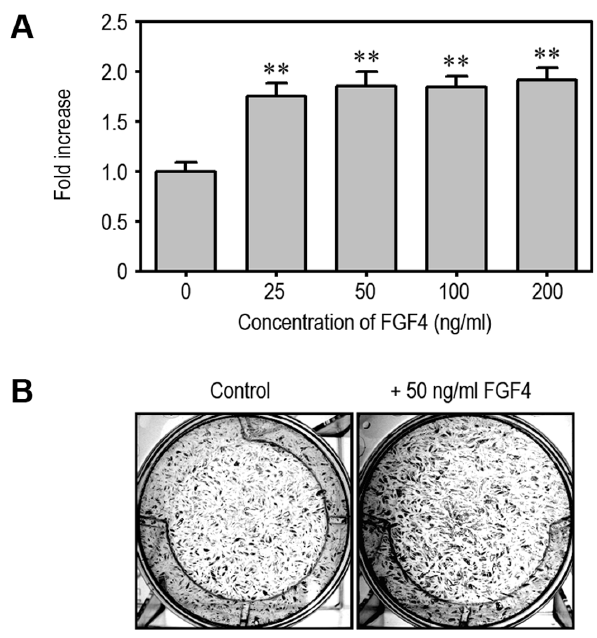
Figure 1. FGF4 increases proliferation of mESCs. mESCs were incubated in the presence of 0 to 200 ng/ml FGF4 in 96-multiwell plates or with the indicated concentration of FGF4 in 6-well culture plates for 48 h and then further processed for BrdU incorporation assay (A) and hematoxylin staining (B), respectively. Experimental results shown in (A) represent the mean 6 SD from three separate experiments. **p , 0.01 indicates a significant difference between experiments and untreated control